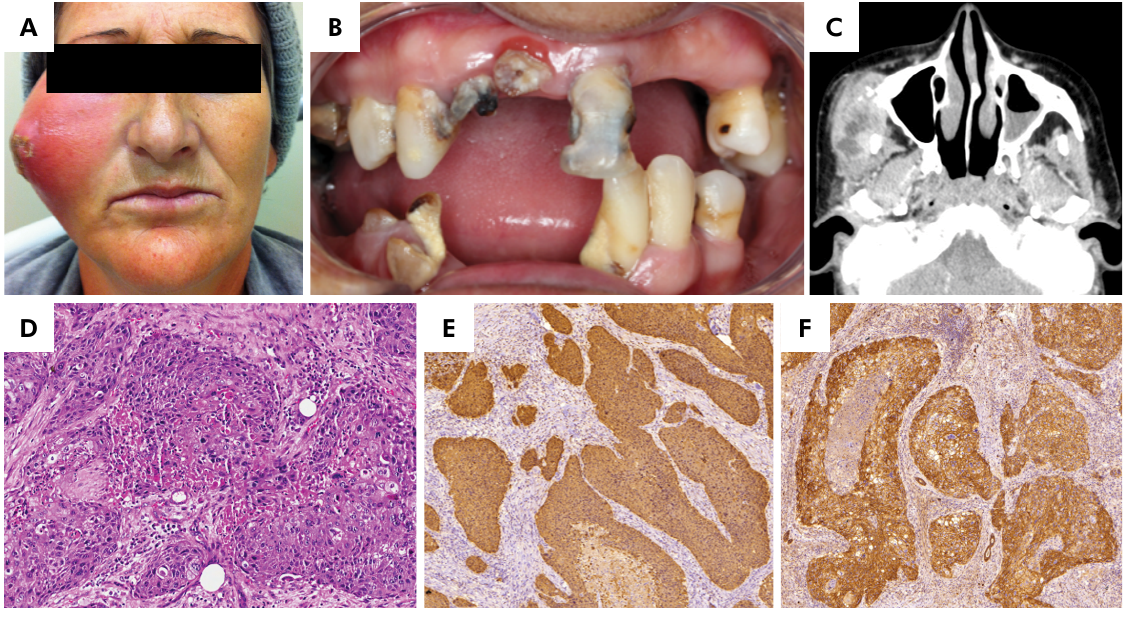
Figure 2. Clinicopathological aspects of metastatic breast carcinoma affecting the zygomatic bone. The history of a recent radical mastectomy due to invasive ductal carcinoma of the left breast was essential in the diagnostic process. 2A. A 38-year-old female patient was referred for evaluation of a “dental abscess”, presenting facial swelling with an ulcerated and reddish covering skin in the right zygomatic region. During palpation, it was possible to observe a purulent drainage coming out of the lesion throughout the skin. 2B. Intraoral examination revealed periodontal disease, caries and residual roots. 2C. Computed tomography scan revealed a hyperdense lesion with hypodense areas (suggestive of necrosis) affecting the right zygomatic bone and infiltrating the left masseter muscle (axial section, soft tissue window). 2D. Based on the previous medical history of the patient, the diagnostic hypothesis was metastatic breast carcinoma. Incisional biopsy demonstrated islands of atypical squamous cell proliferation (hematoxylin-eosin, 200x). 2E. Further immunohistochemical analysis showed positivity for AE1/AE3 (immunohistochemistry, 50x) and 2F. EGFR (immunohistochemistry, 50x). The tumor cells were negative for Cerb-b2, estrogen and progesterone. This immunoprofile was similar to the primary breast tumor. A diagnosis of metastatic breast carcinoma was thus